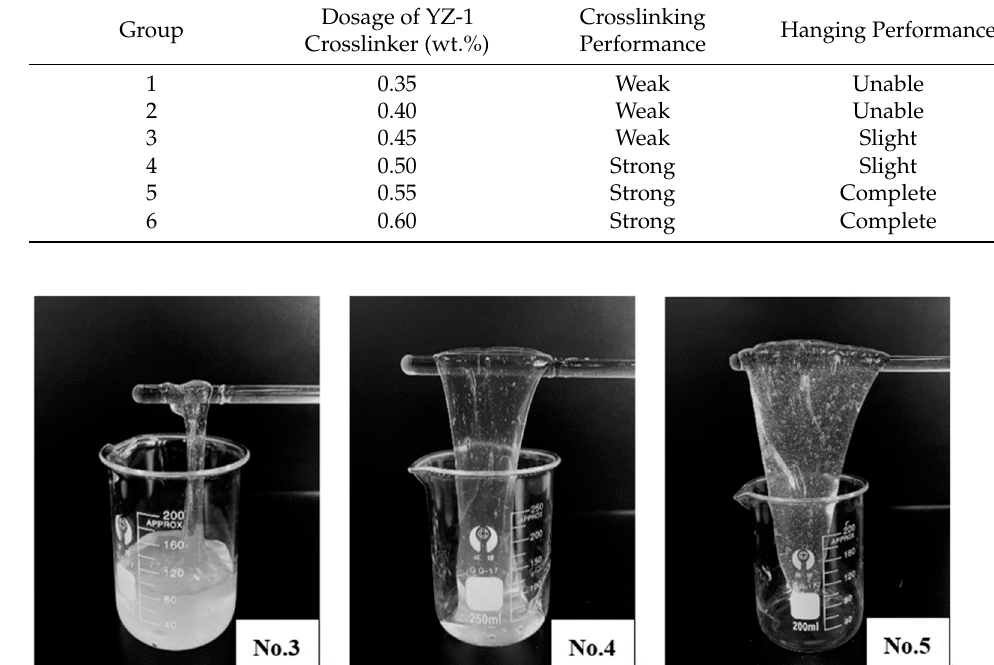
Figure 7. Comparison of different crosslinking and hanging performances. No. 3 shows the experi- mental phenomenon of Group 3 in the Table 5, and No. 4 indicates Group 4 and and No. 5 indicates Group 5.